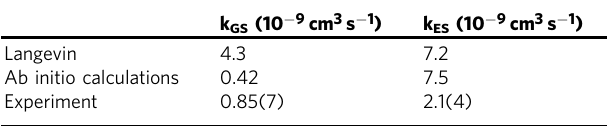
Table 1 Comparison of results from the classical capture theory predictions (Langevin) and the ab initio calculations (modi fi ed capture model), to the experimentally obtained reaction rate coef fi cients (at 355